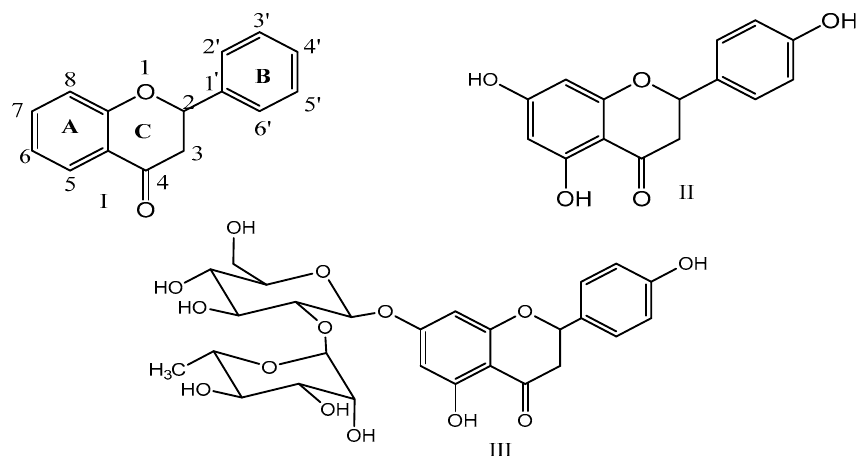
Figure 1. Structures of flavonoids (I); naringenin (II); and naringin (III).